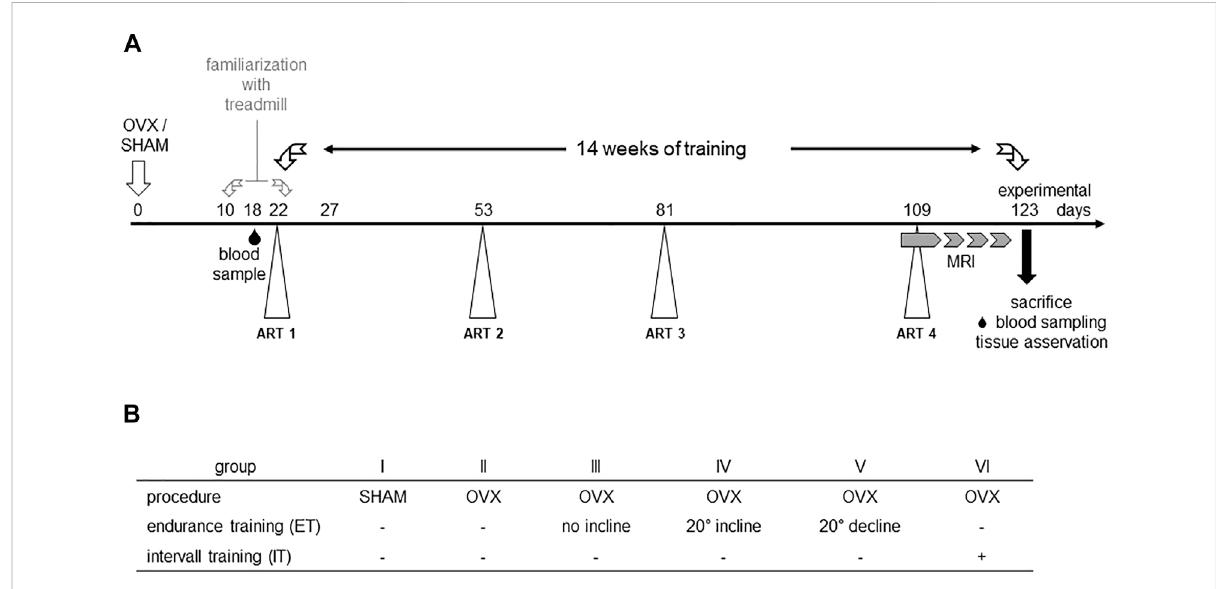
FIGURE 1 Experimental scheme (A) and study groups (B). OVX: ovariectomy, sham: sham operation, ART: Augmentation Run Test, MRI: magnetic resonance